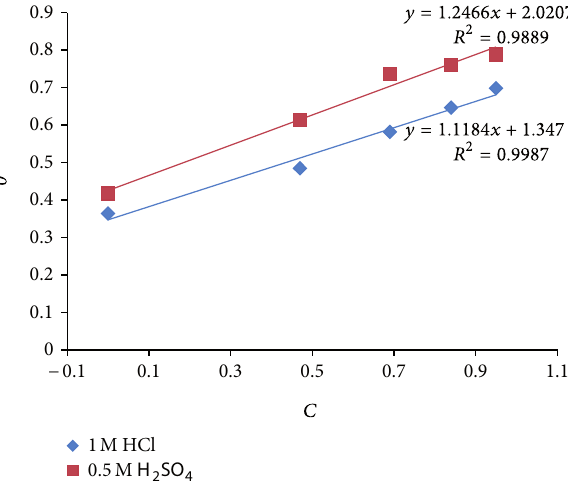
F 5: Temkin adsorption isotherm for inhibitor in 1M HCl and SO . 0.5M H 2 4